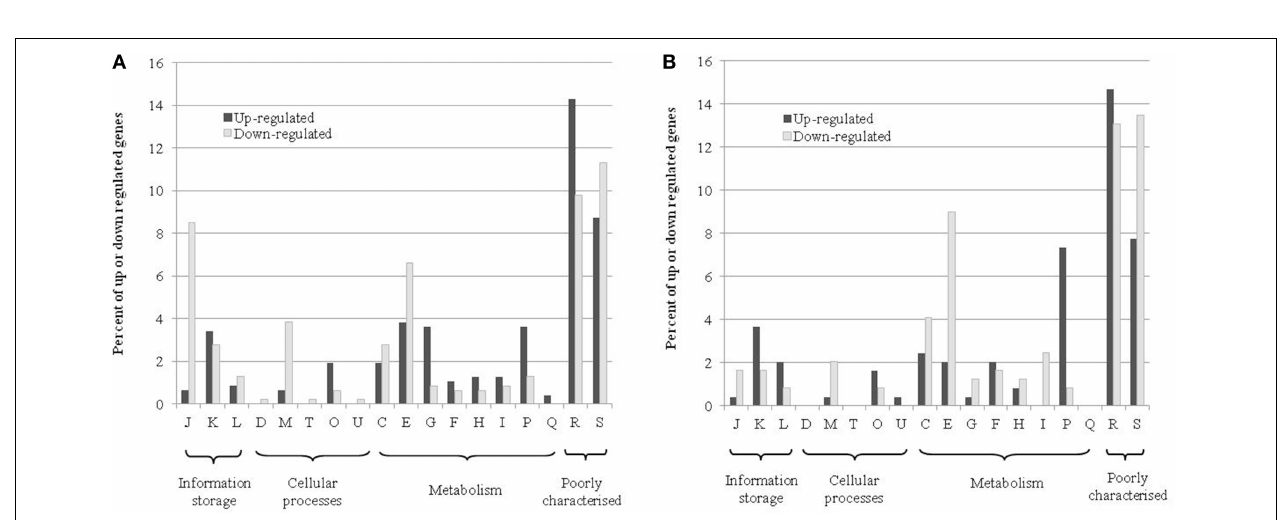
FIGURE 1 | Comparison of log2 expression ratios of 38 differentially regulated genes measured by using microarray and qPCR at t 24h (A) or t 72h (B). Positive and negative log2 expression ratios